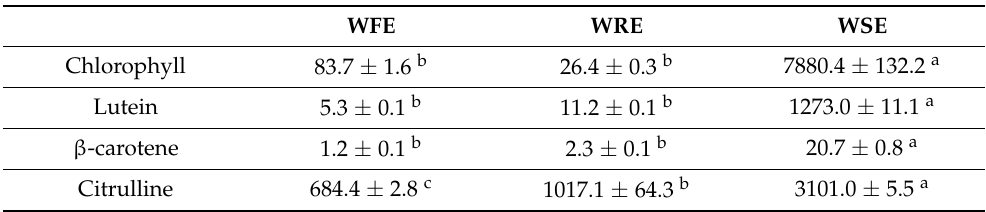
Table 1. Bioactive compounds in watermelon extracts ( µ g/g dry extract for chlorophyll, lutein, β - carotene, and citrulline).